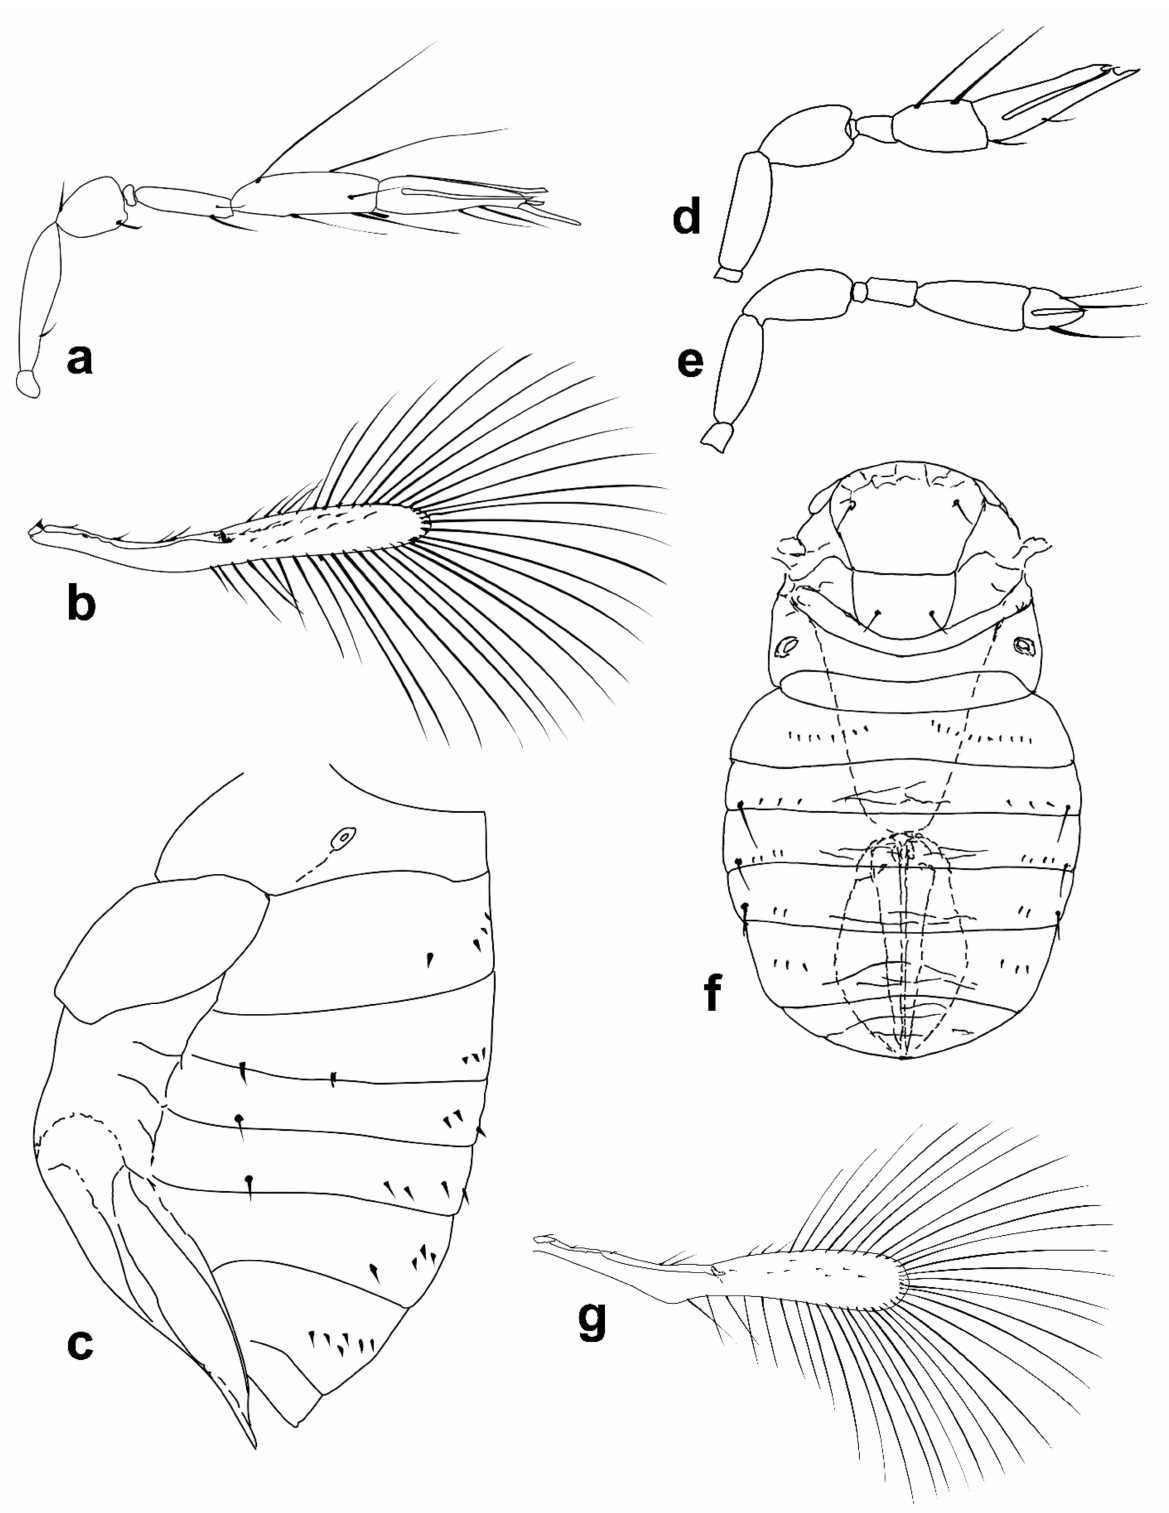
Figure 8. Line drawings of Megaphragma species: ( a ) M. polychaetum , female antenna (Paratype); ( b ) M. polychaetum , female fore wing (Paratype); ( c ) M. polychaetum , female propodeum and metasoma, lateral view (Paratype); ( d ) M. priesneri , female antenna (Neotype); ( e ) M. priesneri , male antenna (non-type); ( f ) M. priesneri , female dorsal meso- and metasoma (Neotype); ( g ) M. priesneri , female fore wing